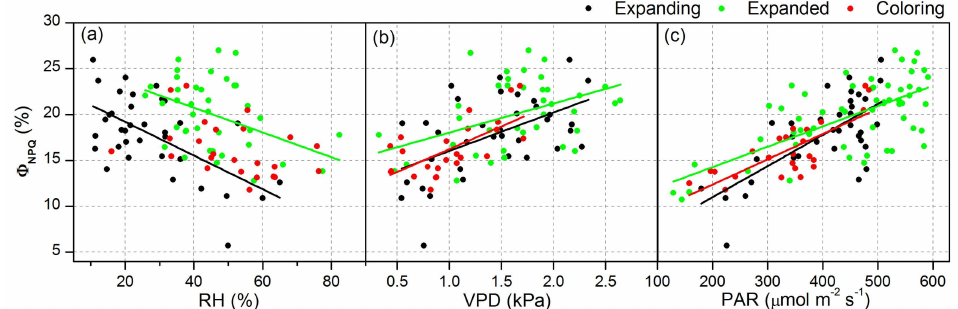
Figure 7. Response of quantum yield of regulatory light-induced non-photochemical quenching ( Φ NPQ ) to daily mean air relative humidity (RH, ( a )), atmospheric vapor pressure deficit (VPD, ( b )), and incident photosynthetically active radiation (PAR, ( c )) for each phenophase. Black, green, and red colored circles and lines coincide with values and fitting functions (Table 1) for the leaf-expanding, expanded, and coloring phases, respectively. Data from rainy days were excluded from the